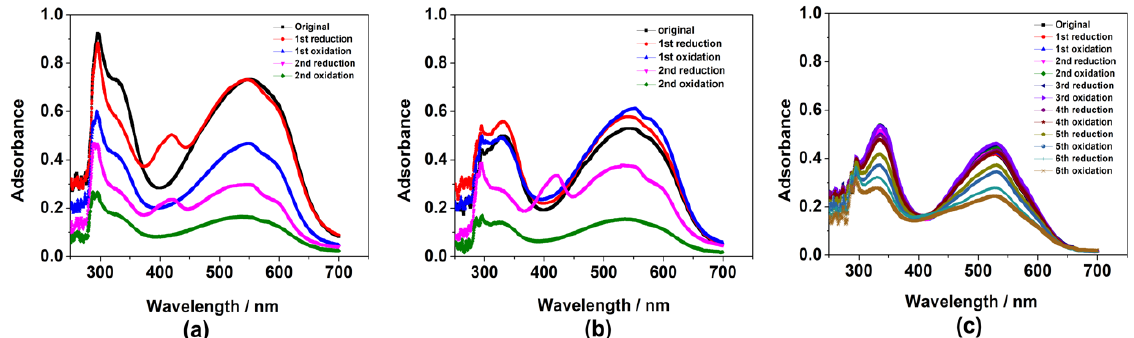
Figure 8. UV–Vis spectra of ( a ) (BPEI/ARS) 120 , ( b ) (BPEI/(ARS+PSS)) 120 and ( c ) ((BPEI+ARS)/PSS) 120 LbL films in 0.1 M NaCl aqueous solutions: after the 1st and 2nd electrochemical reduction (at voltage of − 1.18 V vs. Fe(CN) 64 − /Fe(CN) 63 − ) and oxidation (at voltage of − 0.38 V vs. Fe(CN)6 4 − /Fe(CN) 63 − ) processes.